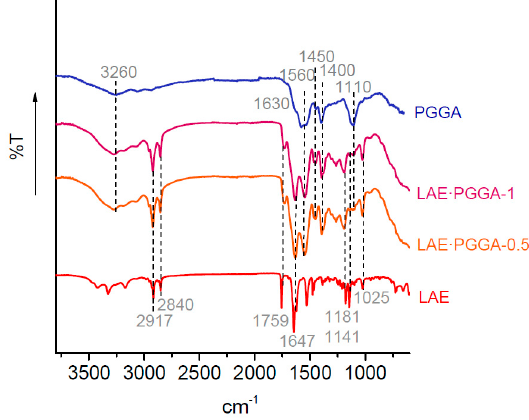
Figure 1. Compared FTIR spectra of LAE, PGGA, and LAE·PGGA complexes.